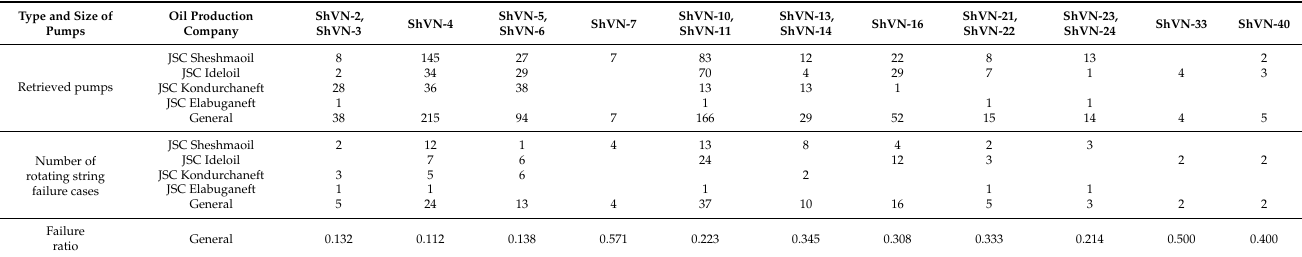
Table 4. Rotating string failures by type and